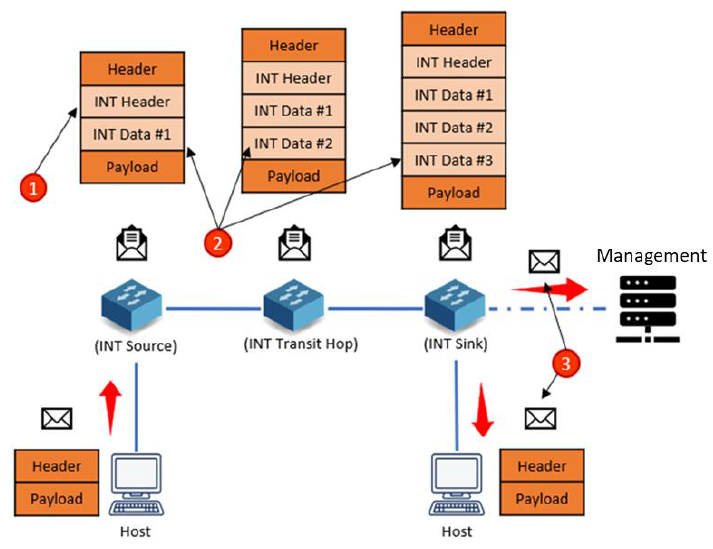
Figure 6. INT procedure.